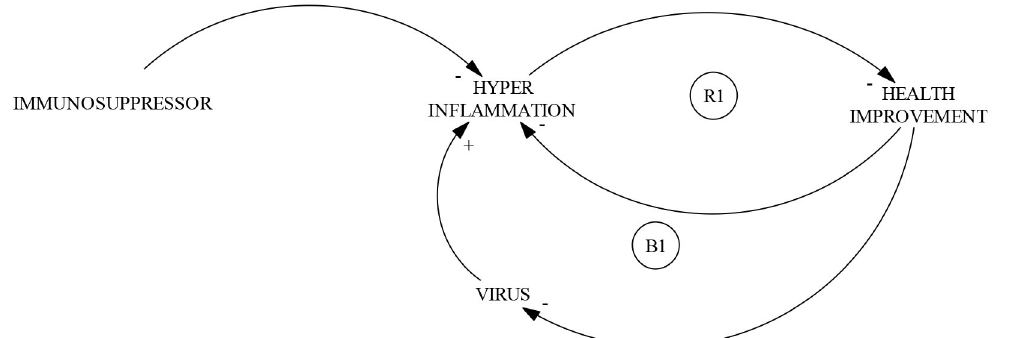
Figure 1. CLD representation of immunosuppressors action in COVID-19. CLD suggests that the action of immunosuppressors in COVID-19 implies the coupling of two cycles, a reinforcing (R1) and a balancing (B1) cycle. CLD is inspired by Hasselbalch et al. [11], who describes the action of SARS-CoV-2 as a mediator of interferon deficiency and hyper inflammation in severe COVID-19 patients. A reinforcing loop between hyper inflammation and health improvement (R1) is important in the evolution of disease thus, the role of immunosuppressors is crucial to diminishing the severity of COVID-19. All CLDs of the present paper were drawn with Vensim